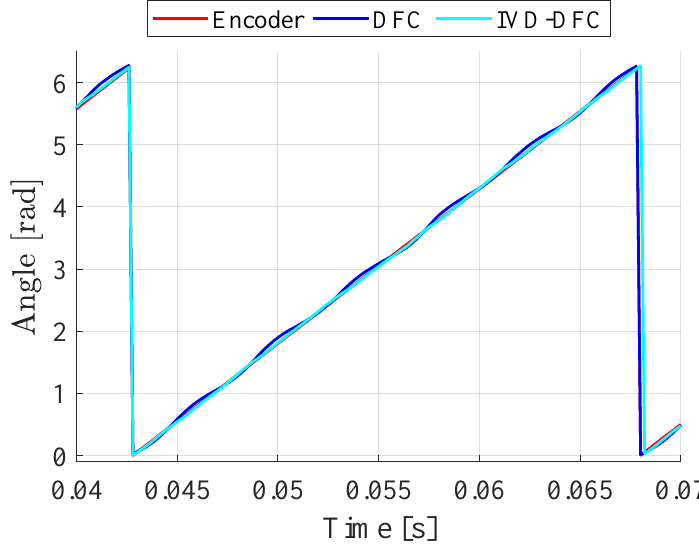
Figure 18. Comparison between encoder, DFC and IVD-DFC electrical angular position. The motor is rotating at 500